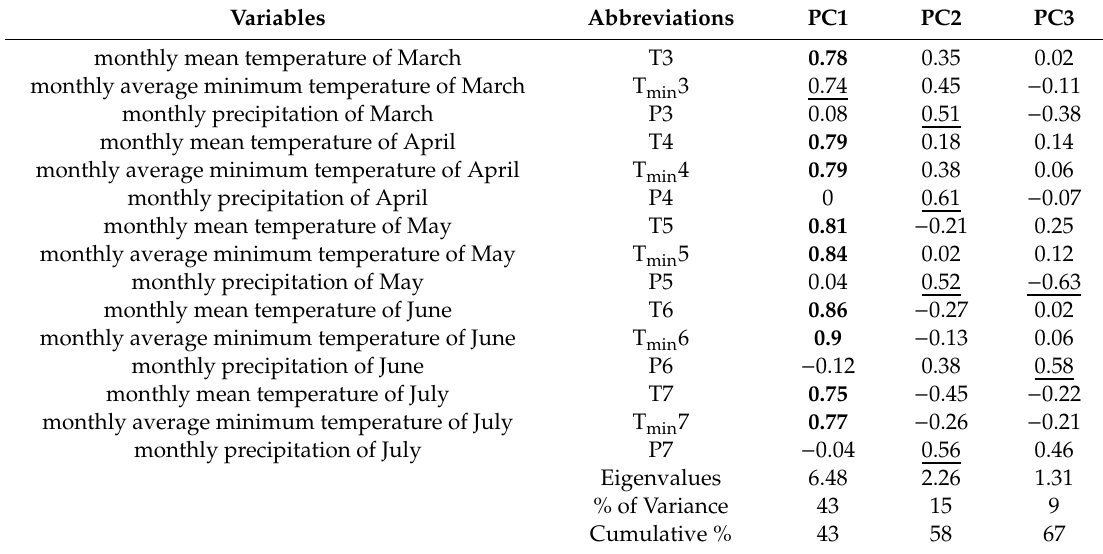
Table 3. Loadings of variables (15) on principal components for Zone III summer